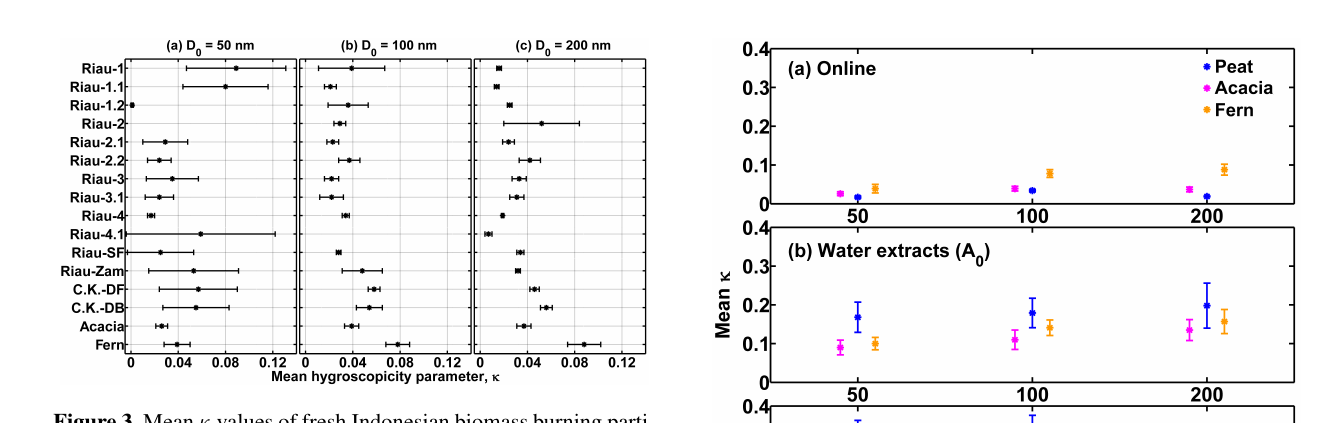
Figure 3. Mean κ values of fresh Indonesian biomass burning parti- cles measured for (a) D 0 = 50nm, (b) D 0 = 100nm, and (c) D 0 = 200nm particles. In all cases, κ values are lower than 0.1. The largest κ values were measured for fern burning particles ( D 0 = 100nm and D 0 = 200nm). Particles emitted from combustion of peat in Central Kalimantan are generally more hygroscopic than those from Riau, Sumatra. Error bars denote the corresponding stan- dard deviations.